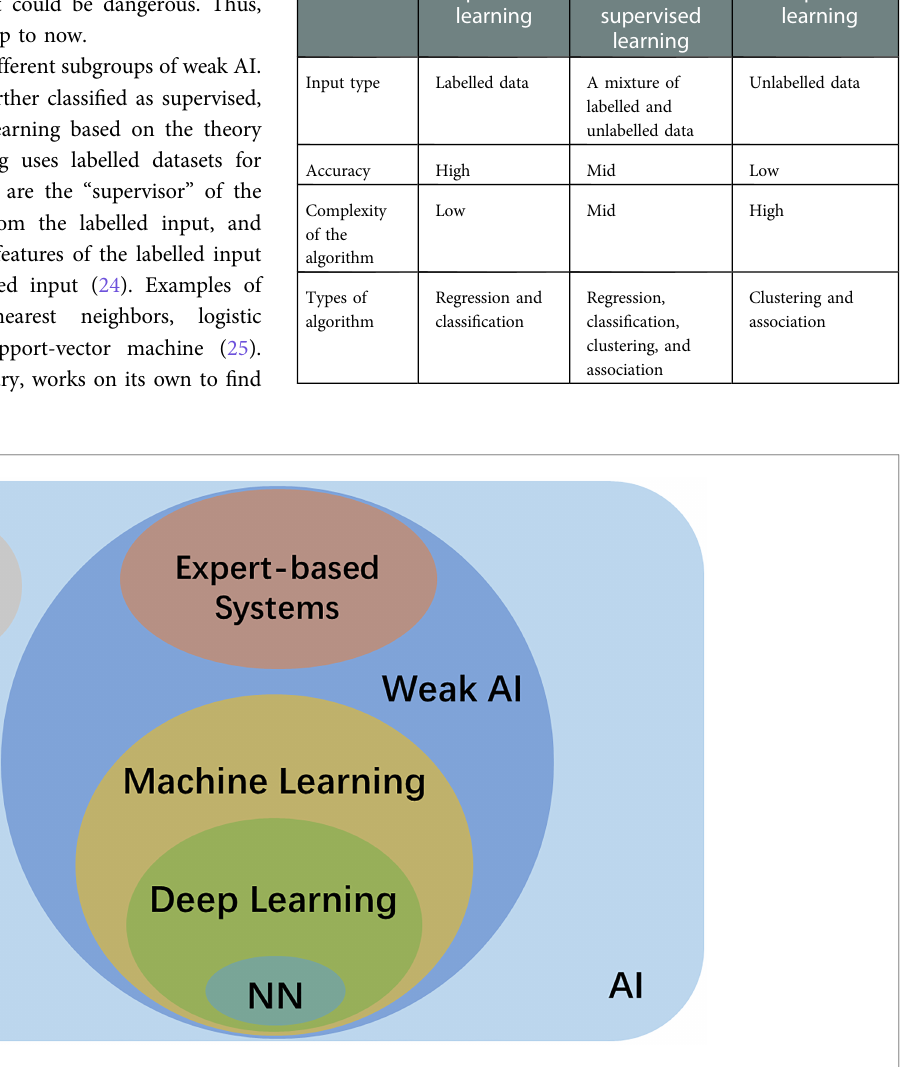
TABLE 1 A comparison of supervised learning, semi-supervised learning, and unsupervised learning. Items Supervised Semi- learning